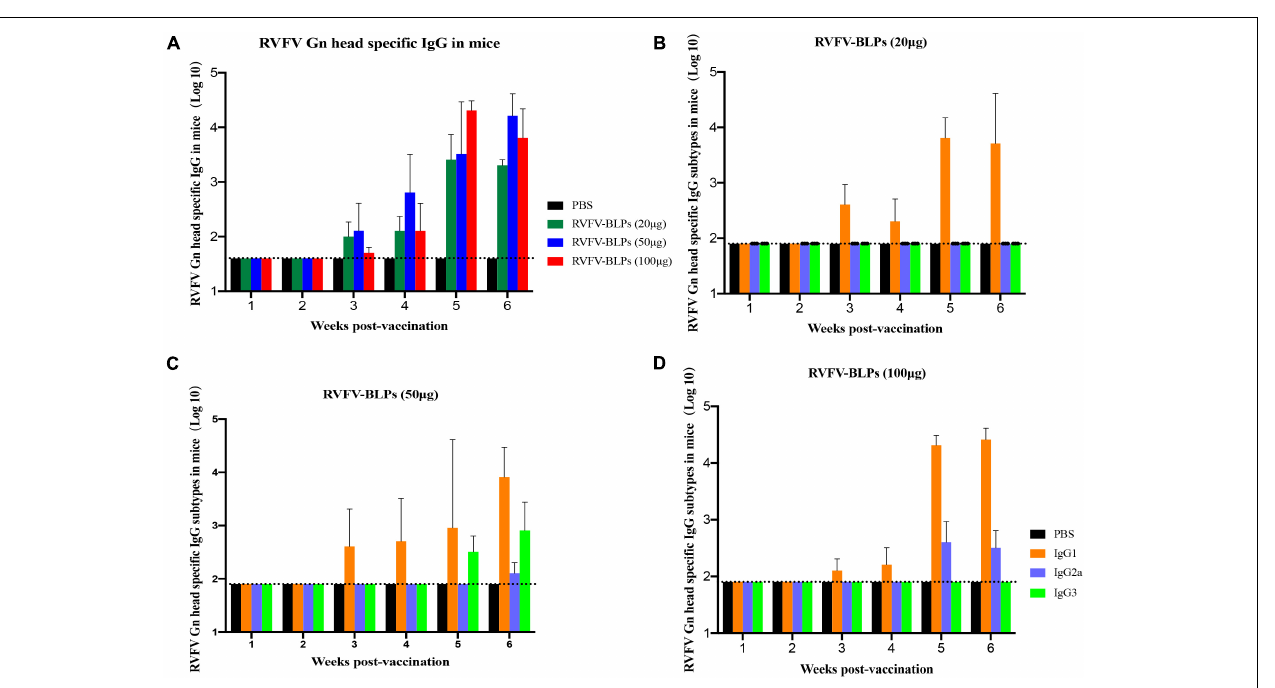
2 weeks after the third immunization could inhibit 50% RVFV pseudovirus infection ( Figure 7A